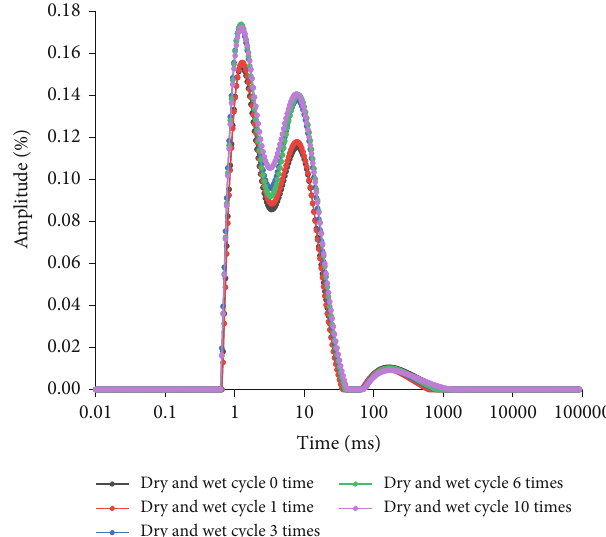
Figure 2: T 2 NMR spectrum of typical samples.